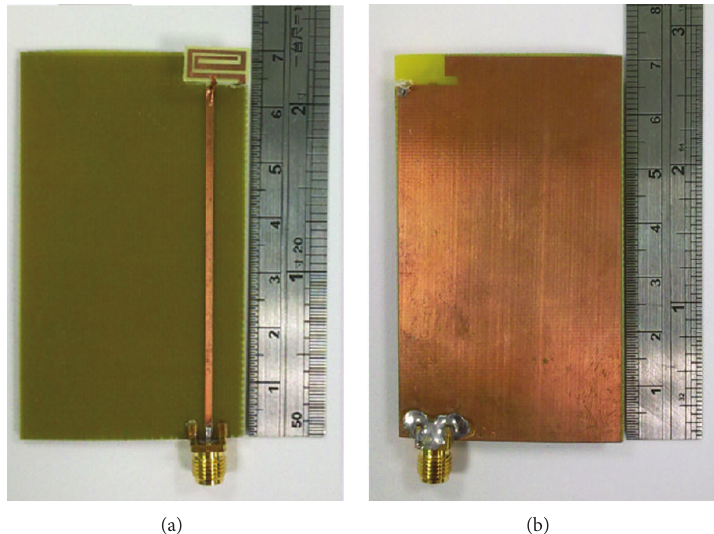
Figure 8: Numerical simulation and experimental measurement return losses for the proposed PIEA with DGS.